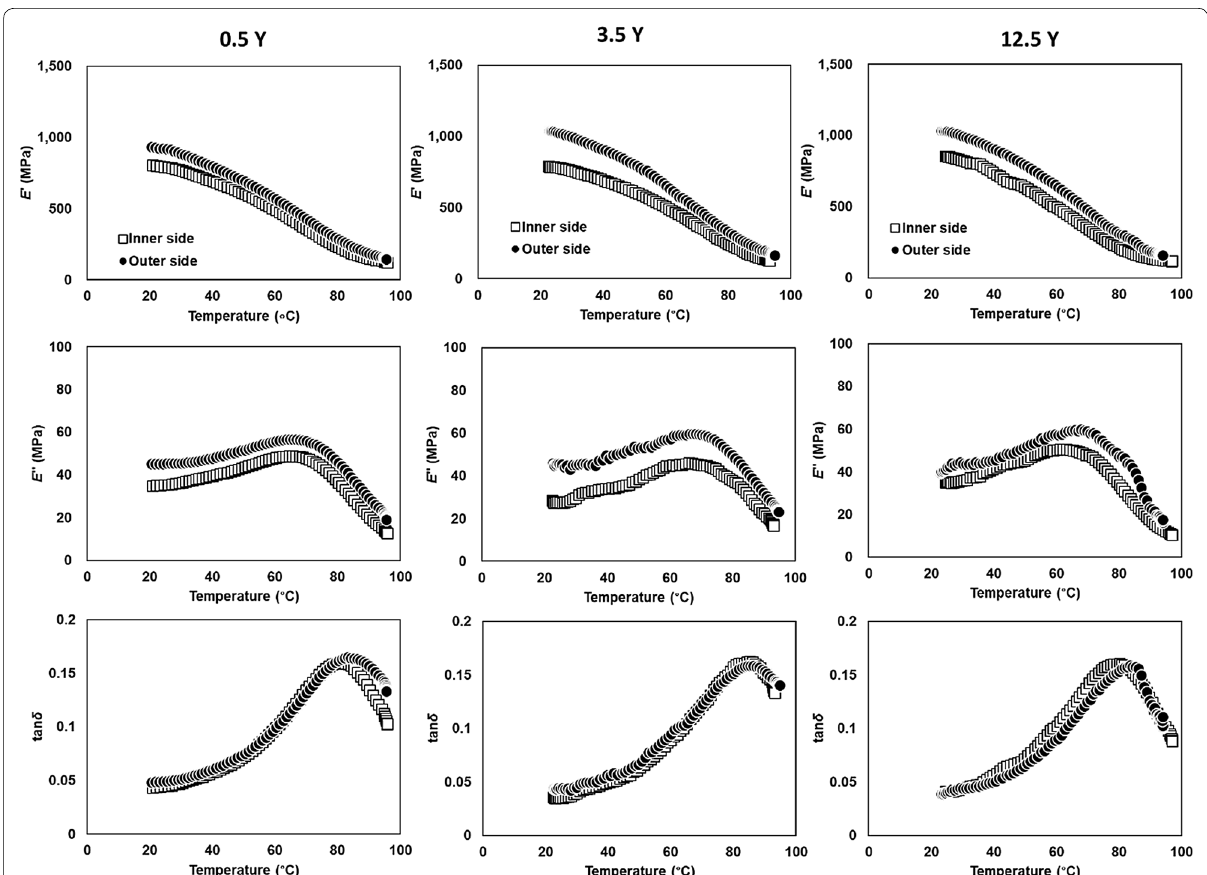
Fig. 3 Temperature dispersion of the storage elastic modulus ( E ′ ), loss modulus ( E ′′ ), and the tan δ of the 0.5-year-old (0.5Y), 3.5-year-old (3.5Y), and 12.5-year-old (12.5 Y) bamboo culms at 0.05 Hz